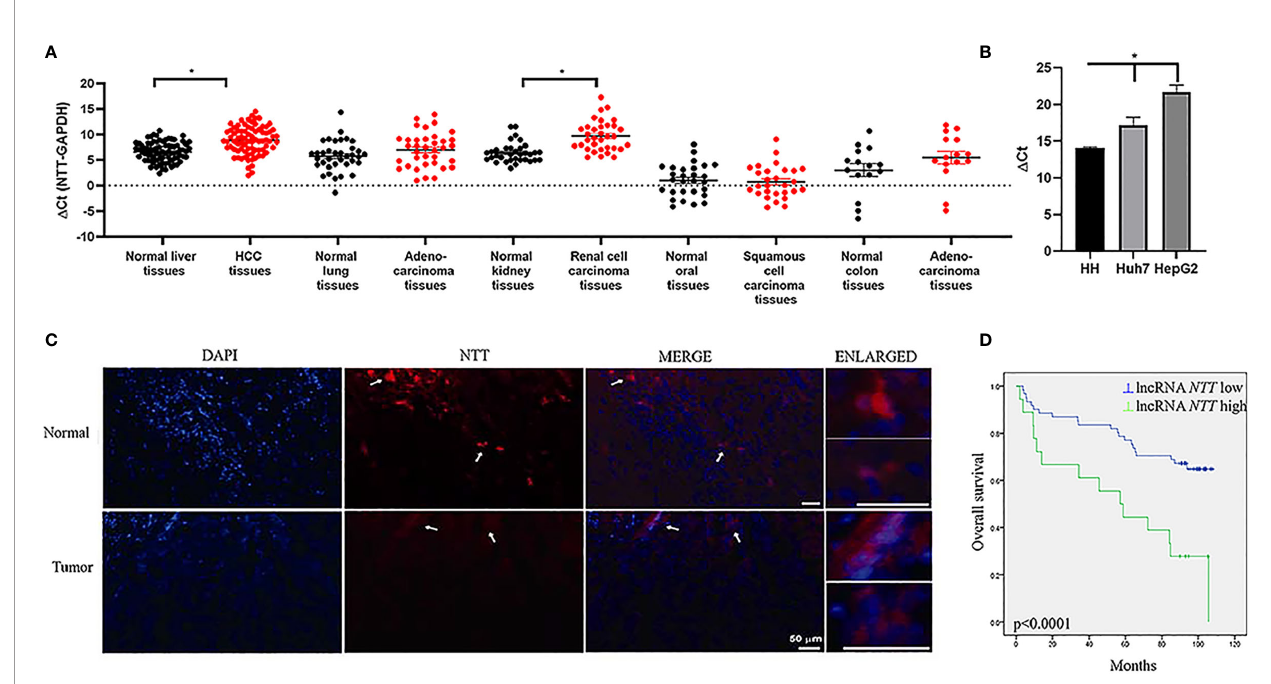
FIGURE 1 | NTT is dysregulated in various cancers. (A) Expression of NTT was evaluated by qPCR in different cancer types. (B) Low expression of NTT in HCC cell lines, including Huh7 and HepG2 in comparison with that in normal primary human hepatocytes. (C) NTT expression was also evaluated in HCC by RNA FISH. (D) High NTT expression indicated a poor clinical outcome. * p <